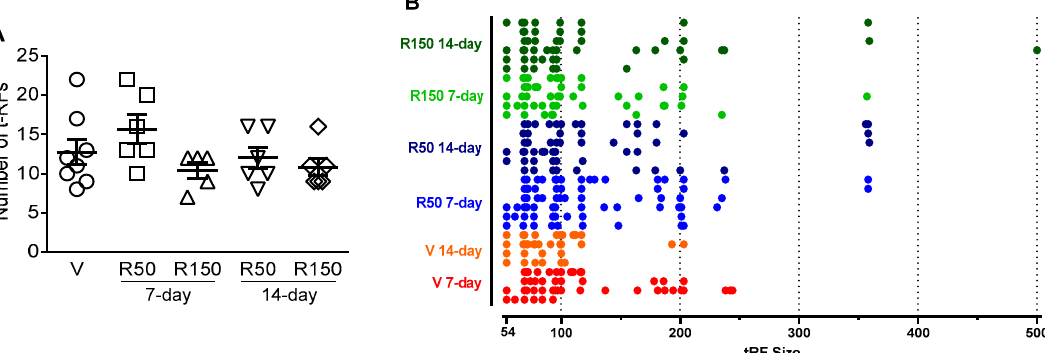
Figure 4. Ecological characterization of the luminal microbiota by T-RFLP analysis: Effects of rifaximin on biodiversity of the ceco-colonic microbiota. ( A ) Number of tRFs detected. Each symbol represents an individual animal; the horizontal lines with errors correspond to the mean ± SEM. For the sake of clarity, and since no differences were observed among them, vehicle-treated animals have been merged in a single group. V: Vehicle; R50: rifaximin at 50 mg/kg; R150: rifaximin at 150 mg/kg. ( B ) Distribution of the tRFs detected according to their size. Each line represents an individual animal and each column a tRF size. tRF distribution indicates a similar microbial biodiversity in all experimental groups, regardless the treatment applied. See also Table 2 for details regarding taxonomical classification of the tRFs detected.